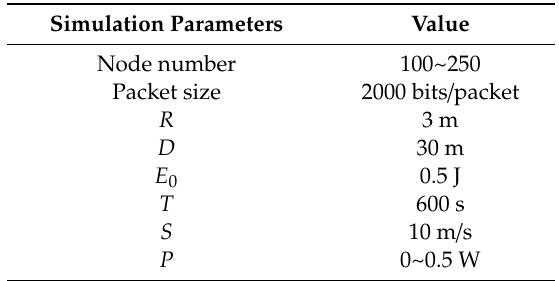
Table 1. Simulation parameters.